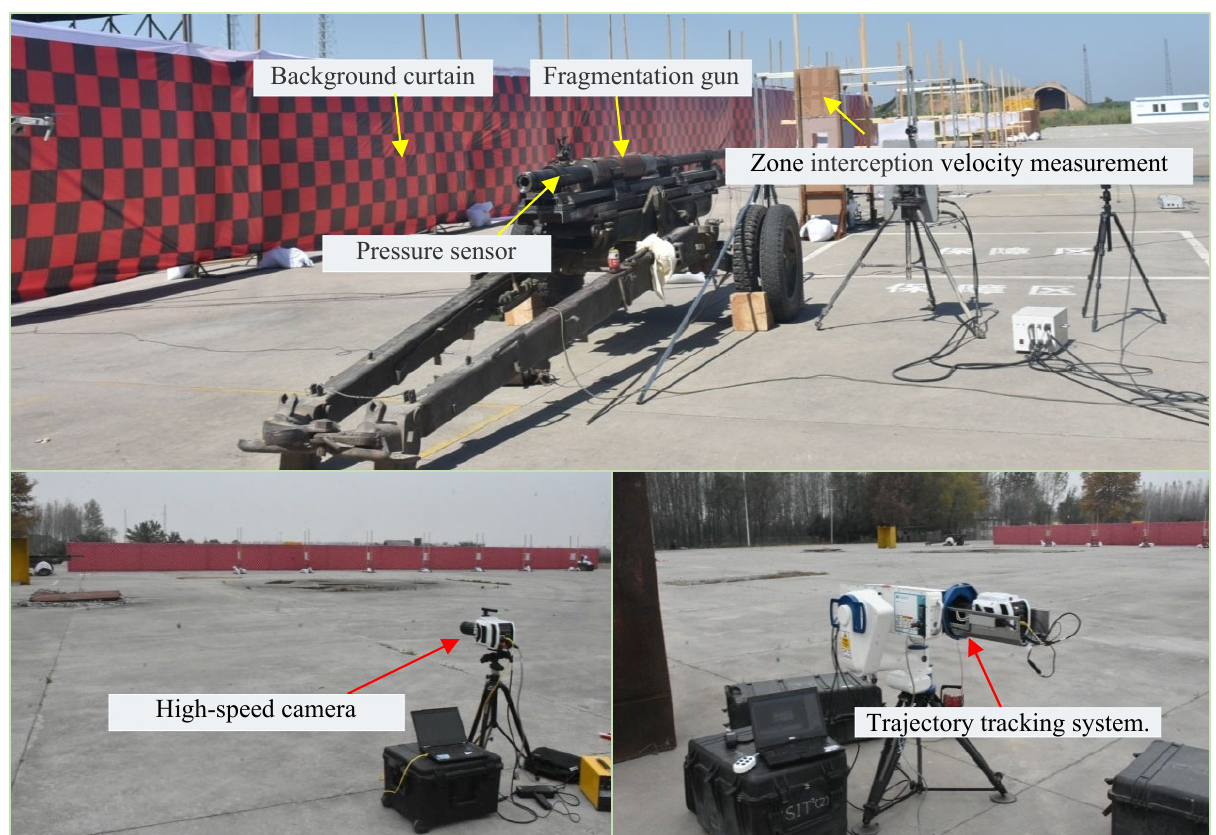
Figure 4. Layout diagram of testing area. Table 2. Relationship of propellant charge, chamber pressure, and velocity of the fragment.